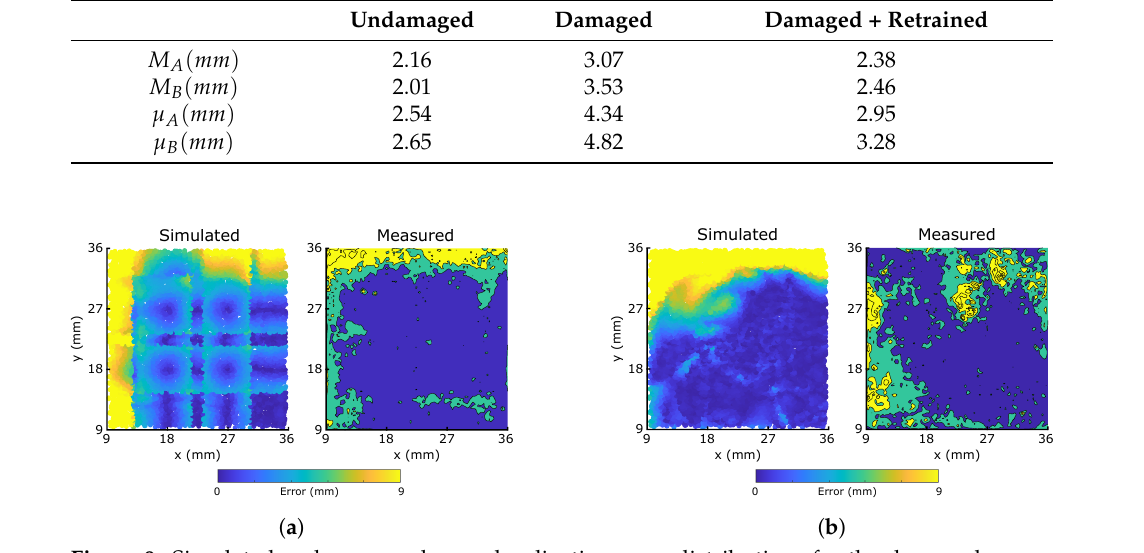
Figure 9. Simulated and measured x − y localization error distributions for the damaged sensor morphologies, before retraining of the neural networks. Two sensors are modeled as damaged (see Figure 5) by replacing their returned values with zeroes. ( a ) Grid; ( b )